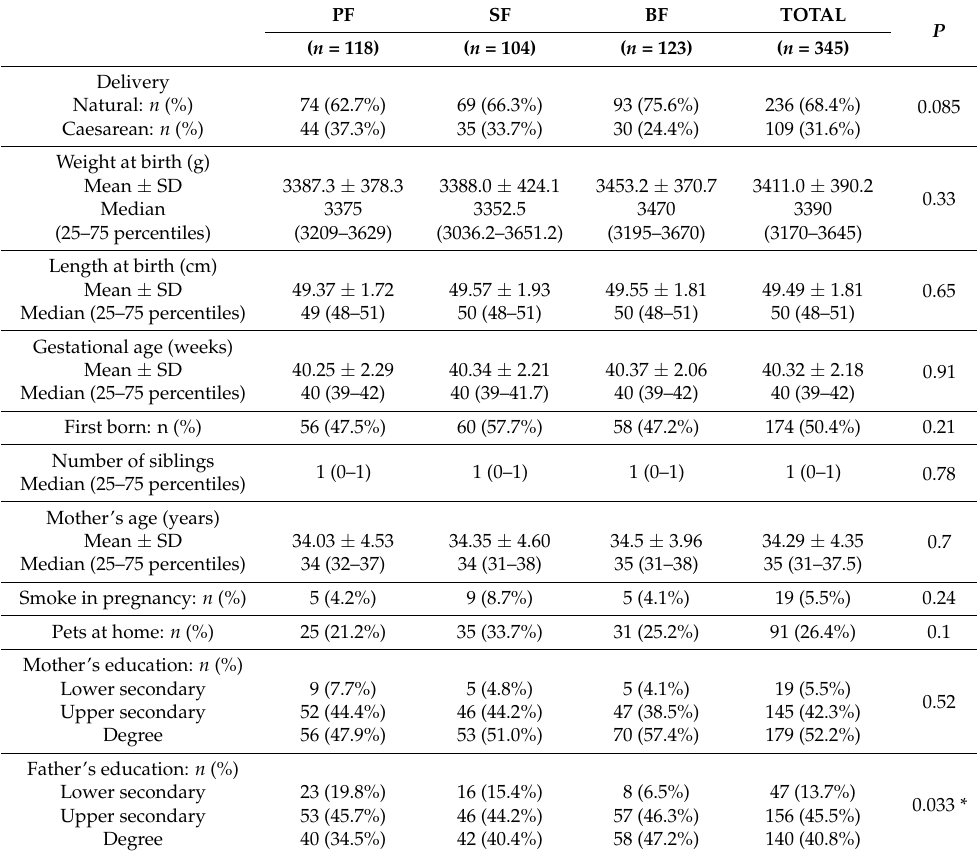
Table 1. Baseline demographic characteristics of the infants per study